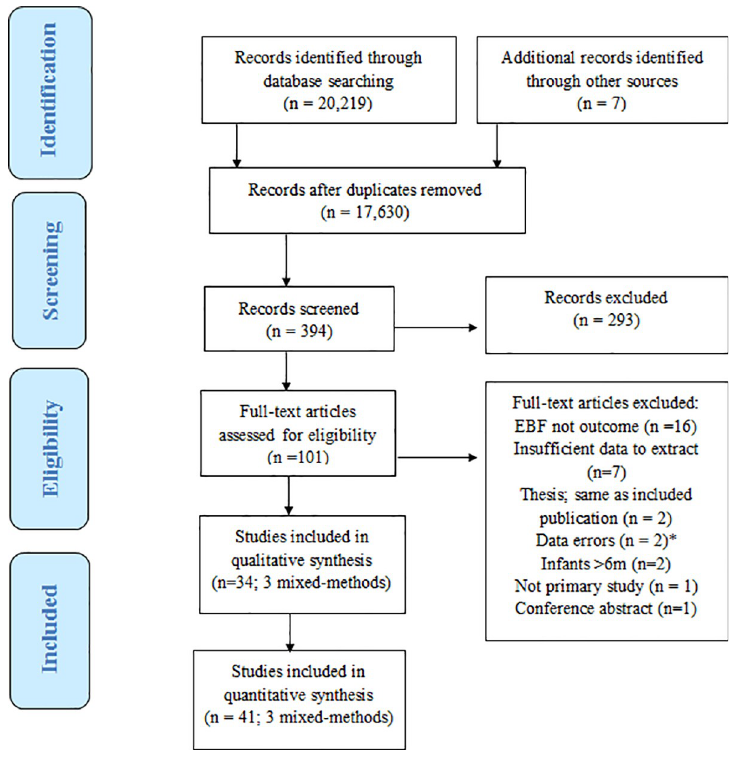
Fig 2. PRISMA flow chart on EBF supports in the first 6 months